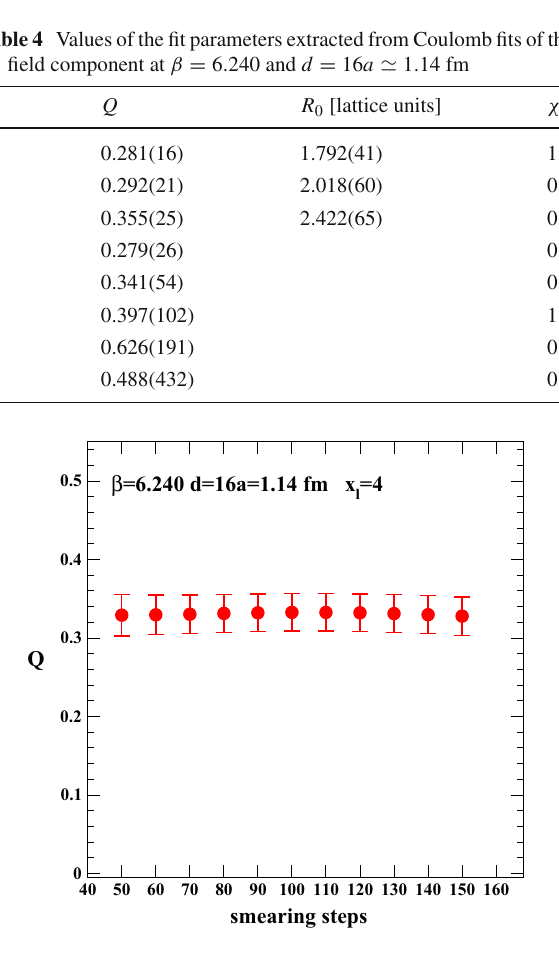
In Fig. 12 we compare the profiles of the y - and z -compo- nents of the chromoelectric field on the transverse planes labeled by x l = 0 , . . . , 7 with fitting curves of the form given in (4). The field components were obtained after 100 smearing